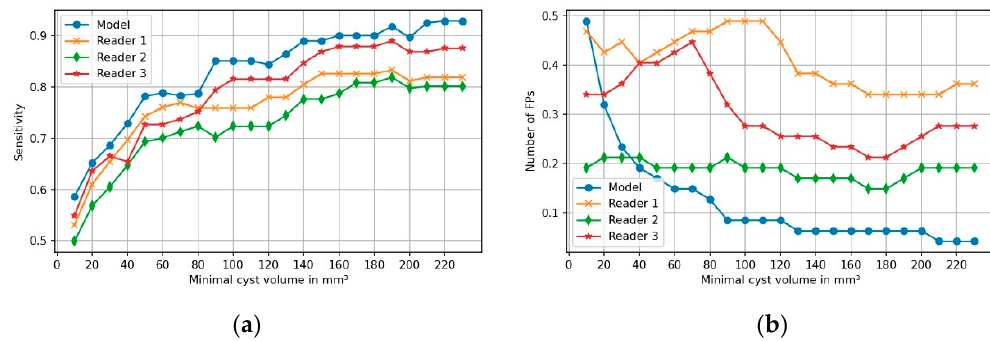
Figure 6. Comparison of the model with three human readers for ( a ) detection rates of PCL and ( b ) false-positive findings per case, as a function of cysts’ volumes. Of note, this analysis is based on a subset of 47 CTs.